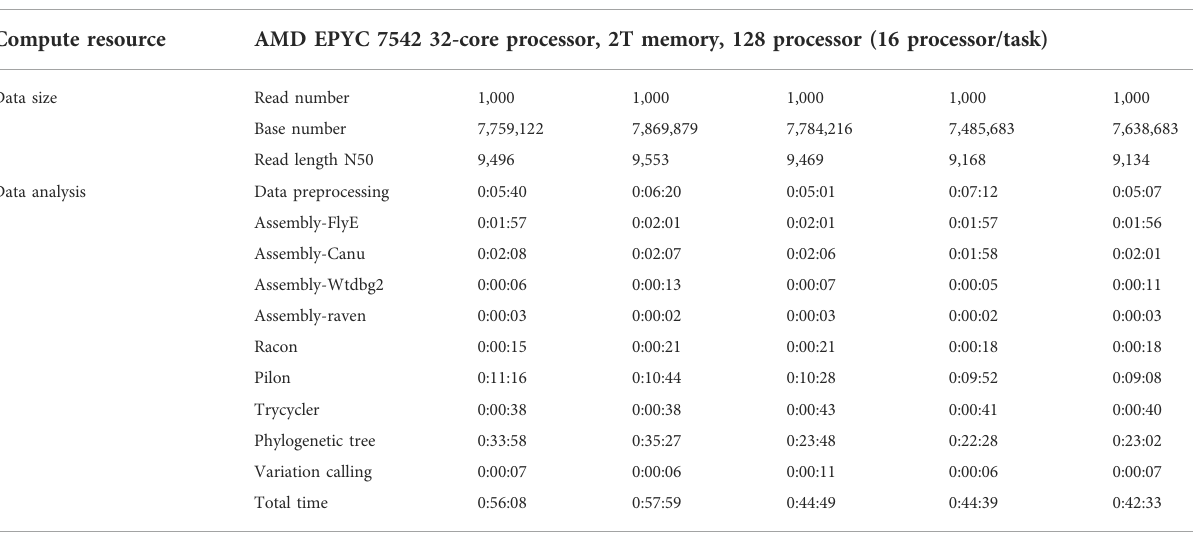
TABLE 1 Running time during each step of the fi ve